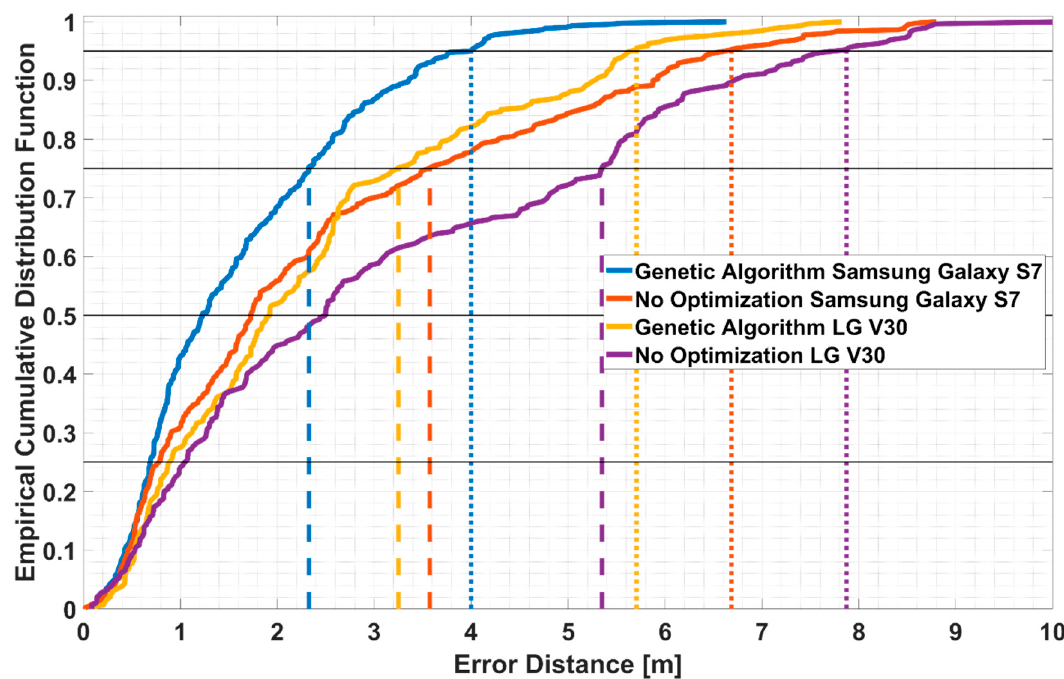
Figure 11. Empirical Cumulative Distribution Function of all evaluation runs for the optimized and knowledge-based parameter variants for the corresponding dataset.